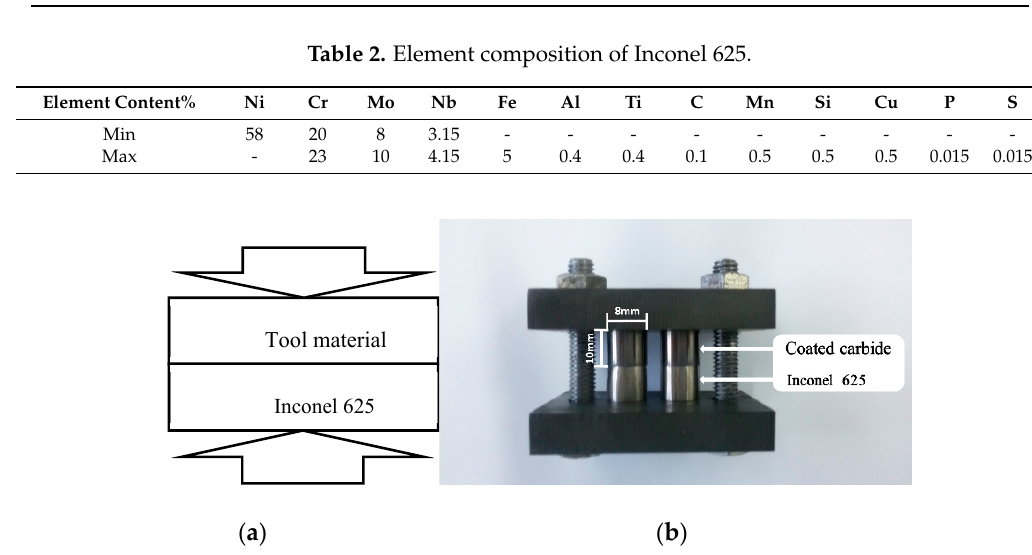
Figure 1. Clamping of the tool material and Inconel 625 specimen.